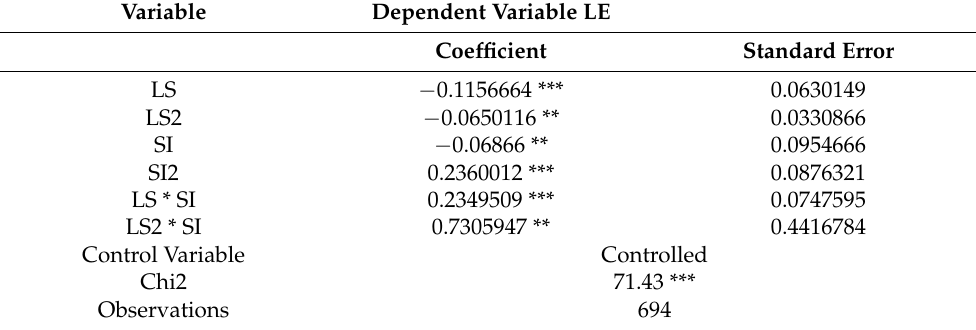
Table 7. Robustness